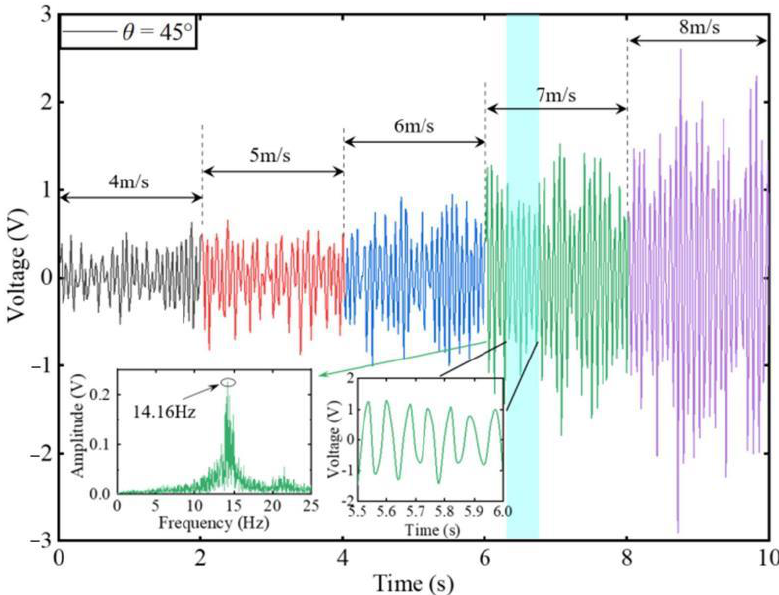
Figure 3. Time domain output voltage in different wind velocities for harvester with square-section cylinder when θ = 45°.